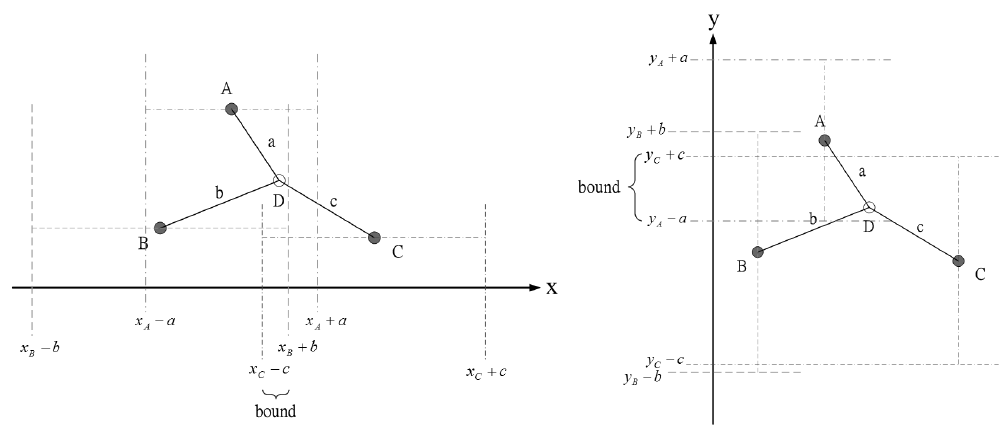
Table 1. The Particle Filtering